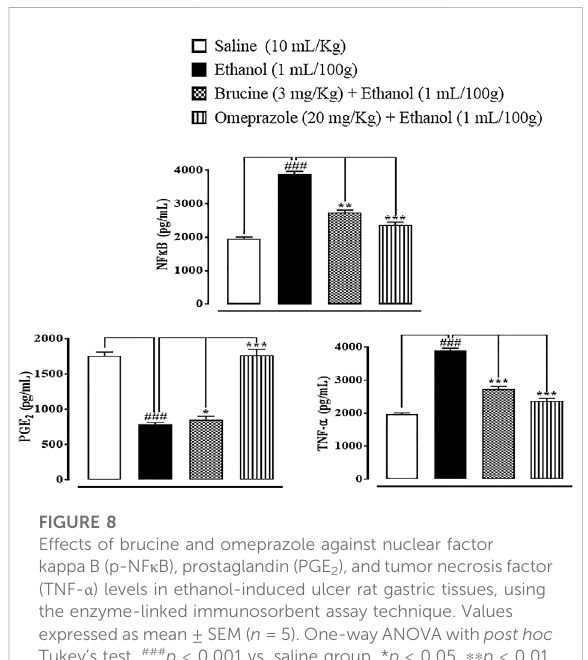
FIGURE 8 Effects of brucine and omeprazole against nuclear factor kappa B (p-NF κ B), prostaglandin (PGE 2 ), and tumor necrosis factor (TNF- α ) levels in ethanol-induced ulcer rat gastric tissues, using the enzyme-linked immunosorbent assay technique. Values expressed as mean ± SEM ( n = 5). One-way ANOVA with post hoc